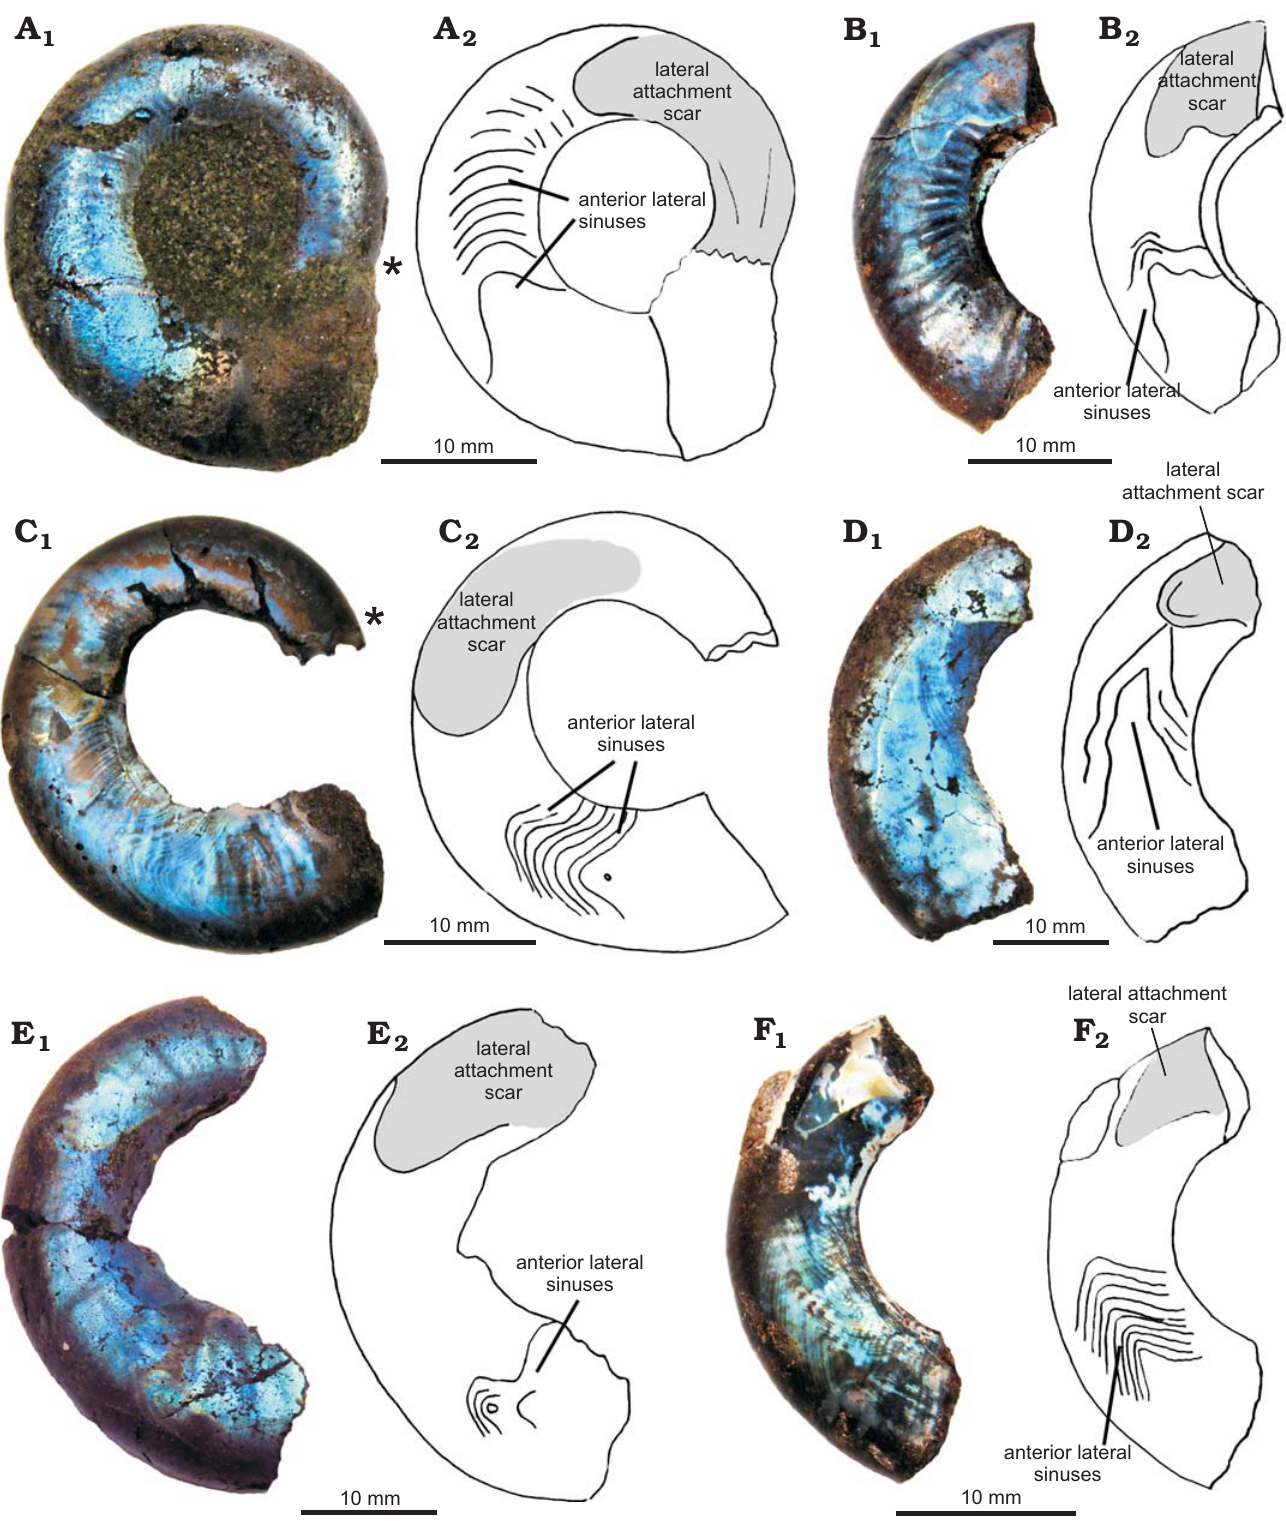
Fig. 10. Lateral attachment scars and anterior lateral sinuses on Kachpurites fulgens (Trautschold, 1861) shells from Late Volgian ( Kachpurites fulgens Zone), Moscow region, Eganovo locality (A, E) and Mnevniki locality (B–D, F). A . MSU 113/20, shell with preserved scar and lateral sinuses. B . MSU 113/12, scars and lateral sinuses on the fragment of the body chamber. C . MSU 113/6, fully preserved body chamber with a scar and frequently located lateral sinuses. D . MSU 113/39, central part of the body chamber with a scar and bright lateral sinuses. E . MSU 113/47, fragment of the body chamber with a scar and clearly visible lateral sinuses. F . MSU 113/15, a part of the body chamber with a front end of a scar and clearly visible frequently located anterior lateral sinus lines. Sinuses are absent near the aperture. Asterisks mark the base of the body chamber. Photographs (A